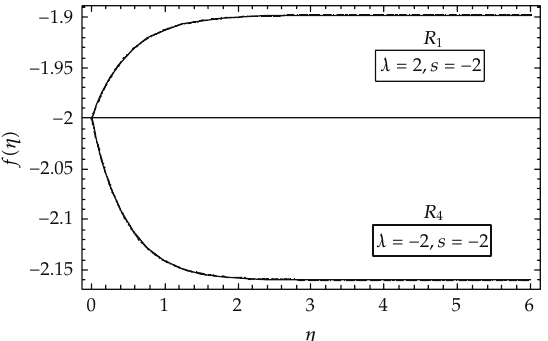
Figure 8: Profiles of the similar stream function f (cid:3) η (cid:4) as a function of η at m (cid:8) − 1 , σ (cid:8) 0 in R 1 , for λ (cid:8) 2 and s (cid:8) − 2, and R 4 , for λ (cid:8) − 2 and s (cid:8) − 2, where solid and dashed lines are for ChPDM and G (cid:2) /G -expansion solutions,